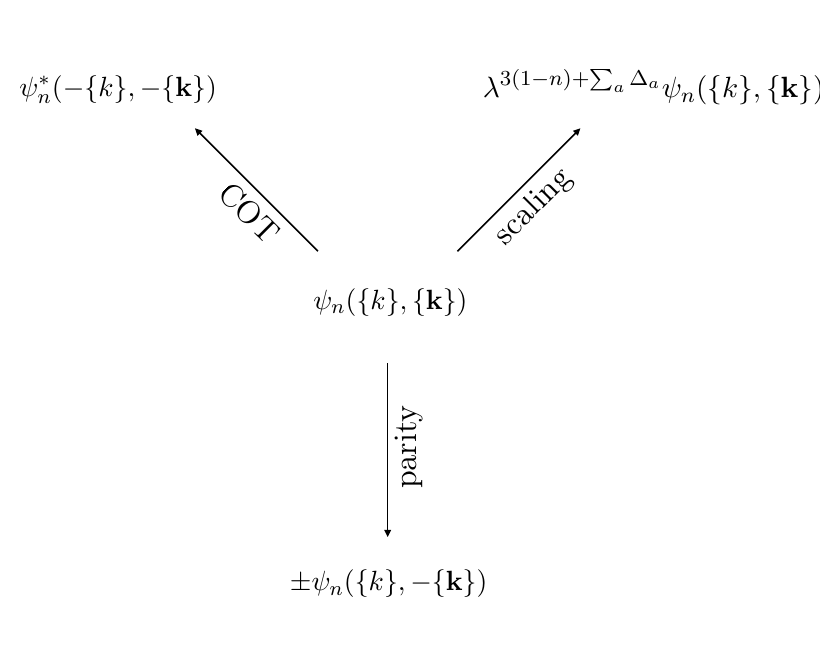
Figure 2 . The flux capacitor in the figure summarises the three main relations that we use to prove a series of no-go theorems for parity odd